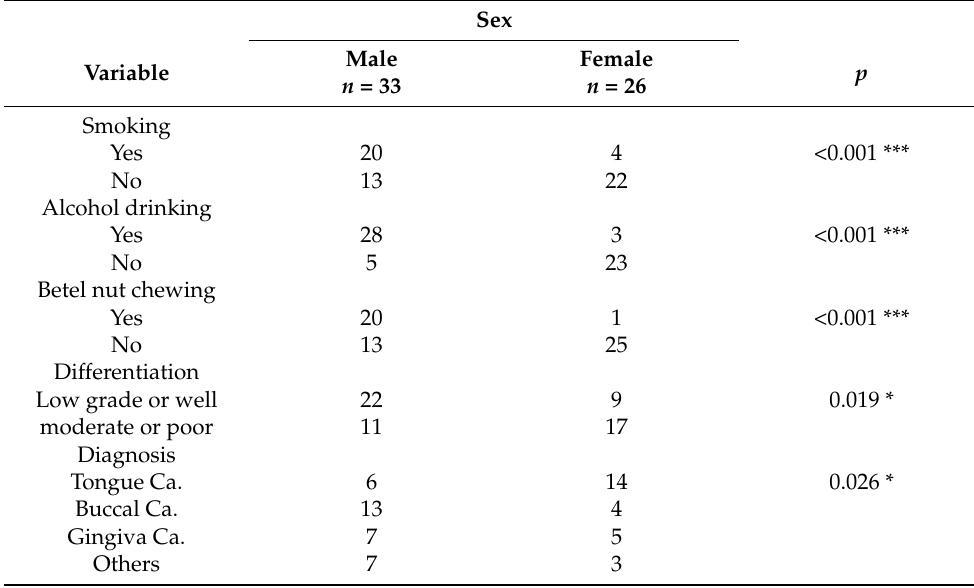
Table 2. The significant difference of clinical characteristics between sexes among OSCC patients.